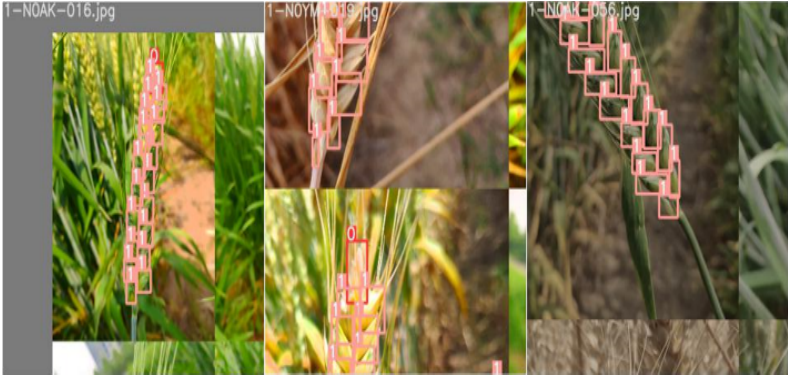
Figure 4. Training pictures with mosaic data